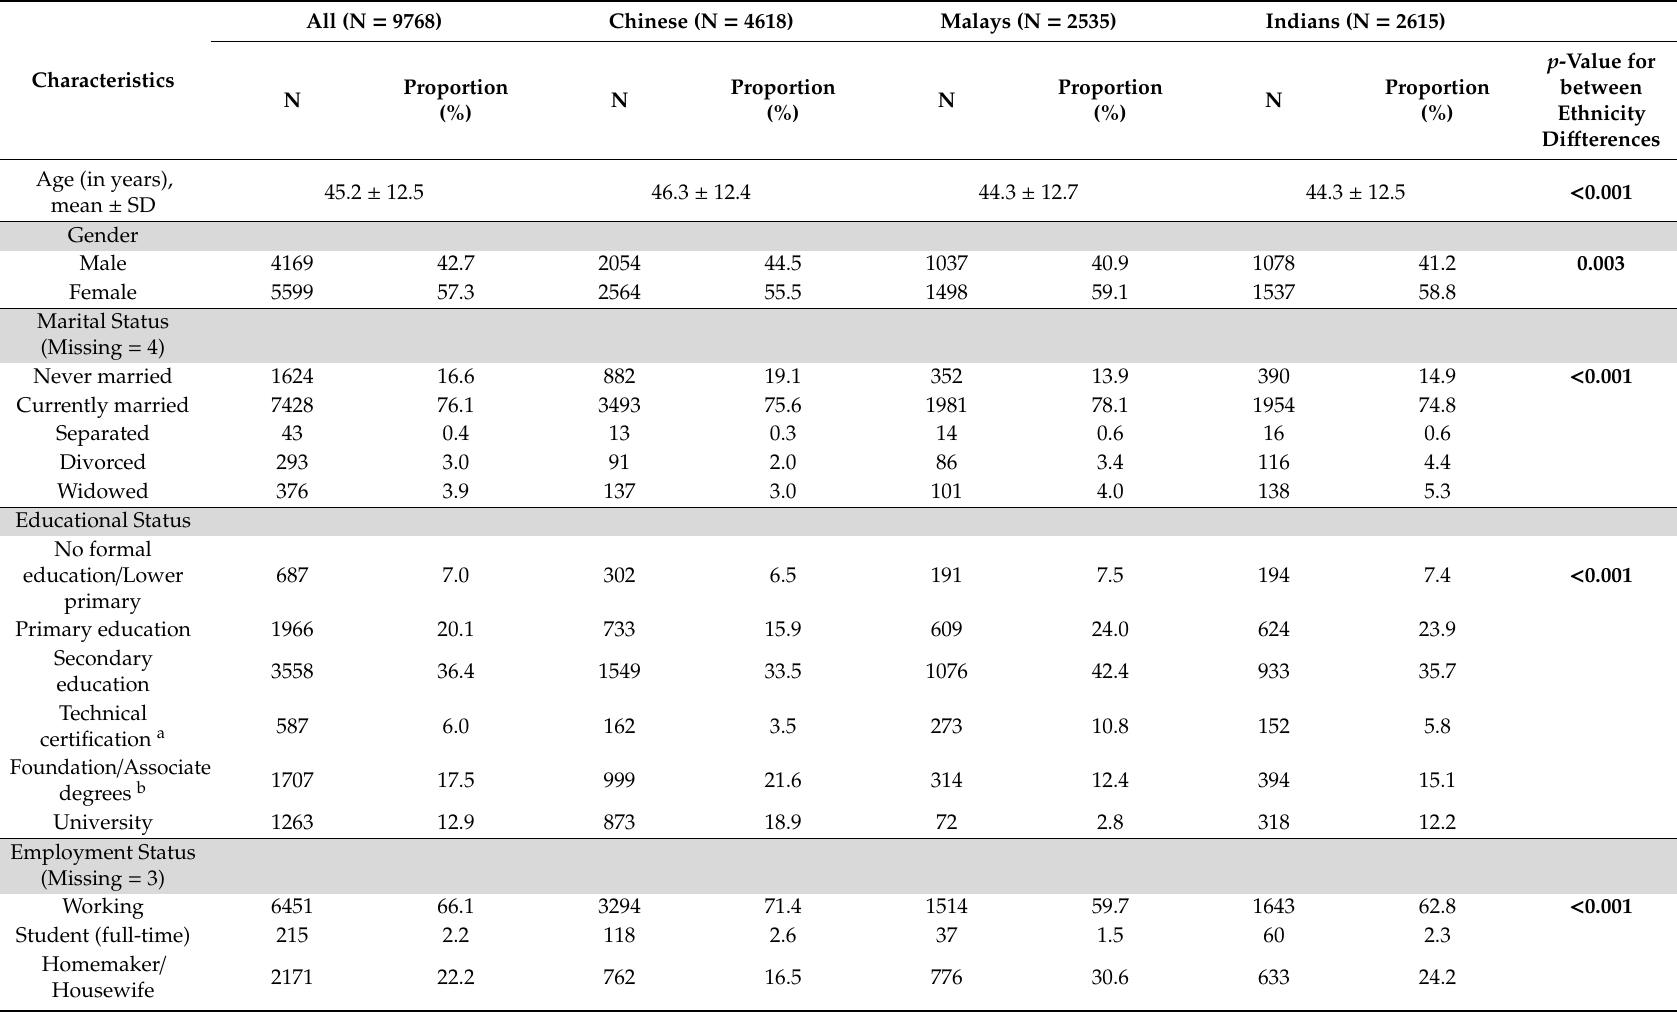
Table 1. Profile of participants (N =